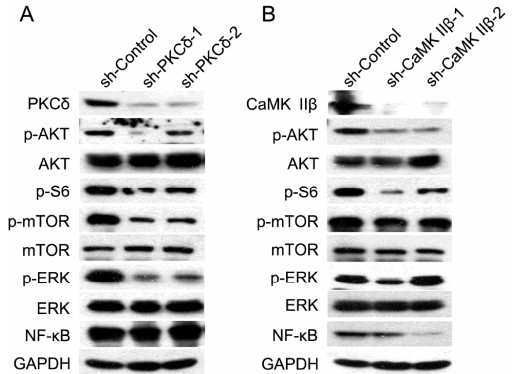
Figure 3. The expression level of Akt, mTOR, S6, and NF- κ B in human gastric adenocarcinoma cells with the transfection of sh-PKC δ or sh-CaMK II β vectors. ( A ) Cells were transfected with sh-PKC δ -2 vector for 48 h. The expression levels of PKC δ , CaMK II β , Akt, p-Akt, mTOR, p-mTOR, p-S6, ERK, p-ERK, and NF- κ B were detected by Western blotting analysis as described in Materials and Methods. GAPDH was used as an internal control; ( B ) Cells were transfected with sh-CaMK II β vector for 48 h. The expression levels of PKC δ , CaMK II β , Akt, p-Akt, mTOR, p-mTOR, p-S6, ERK, p-ERK, and NF- κ B were detected by Western blotting analysis as described in Materials and Methods. GAPDH was used as an internal control. Data are representative of three independent experiments, each yielding similar results.